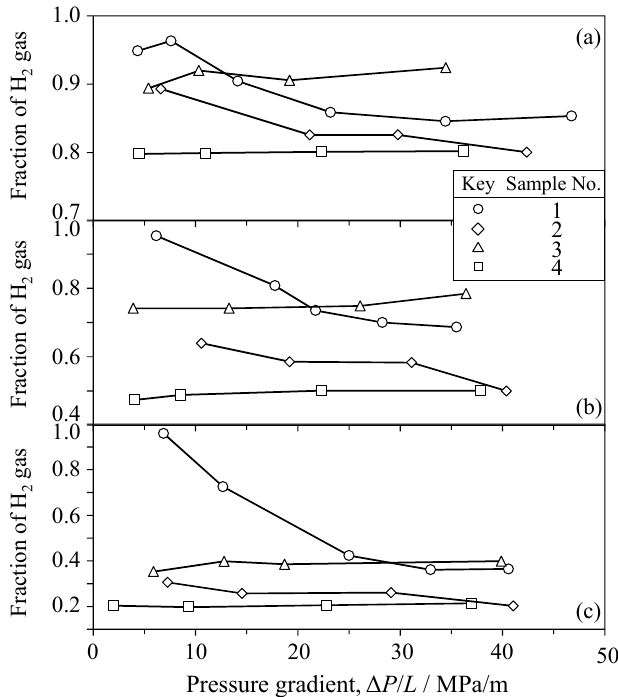
Figure 20. H 2 fractions through the different four samples of Al 2 O 3 sintered at 800 °C for the dried gas of ( a ) 80 vol % H 2 –20 vol % CO 2 ; ( b ) 50 vol % H 2 –50 vol % CO 2 and ( c ) 20 vol % H 2 –80 vol % CO 2 .